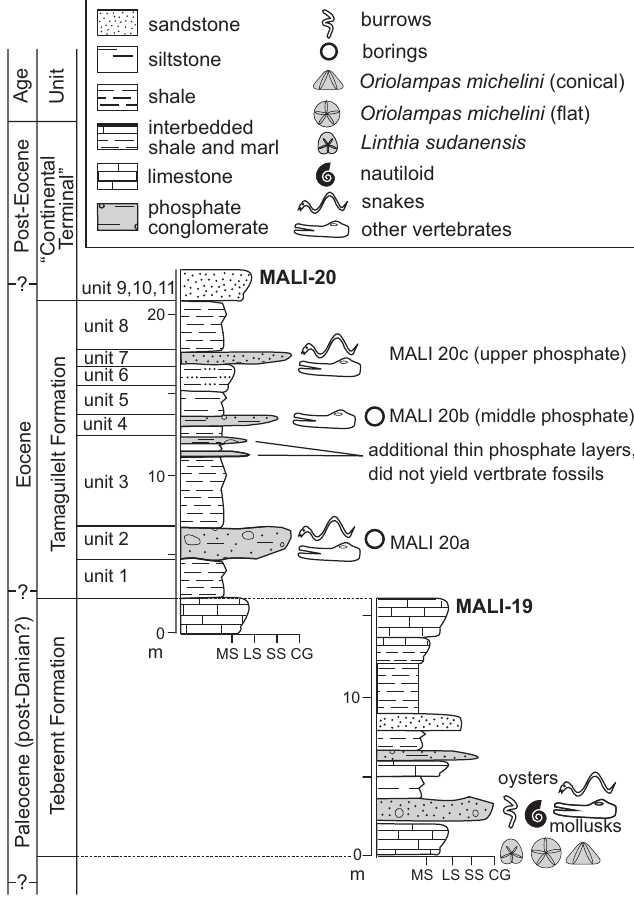
Fig. 3. Correlated stratigraphic sections of the Mali-19 and Mali-20 locali- ties that have yielded snake